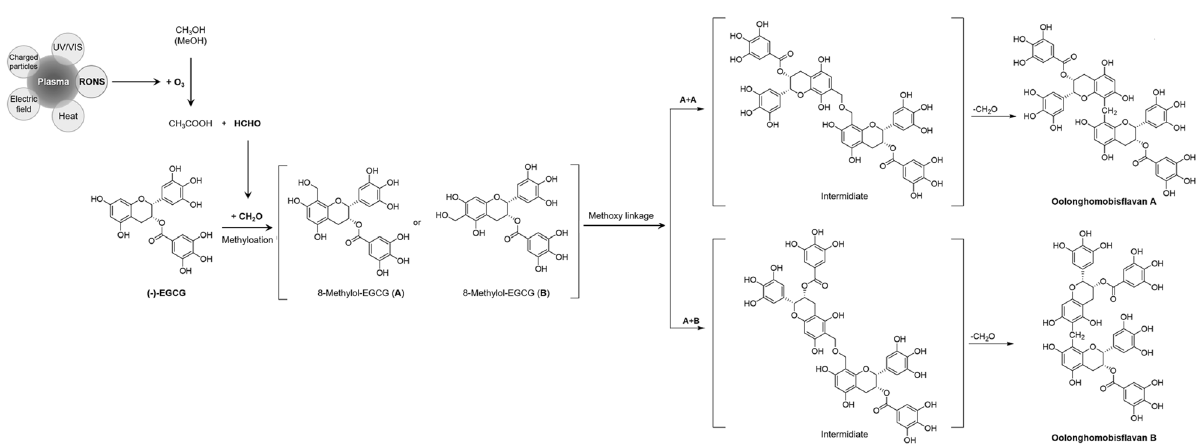
Figure 7. A plausible pathway of the dimerization of EGCG in a methanolic solution by the plasma